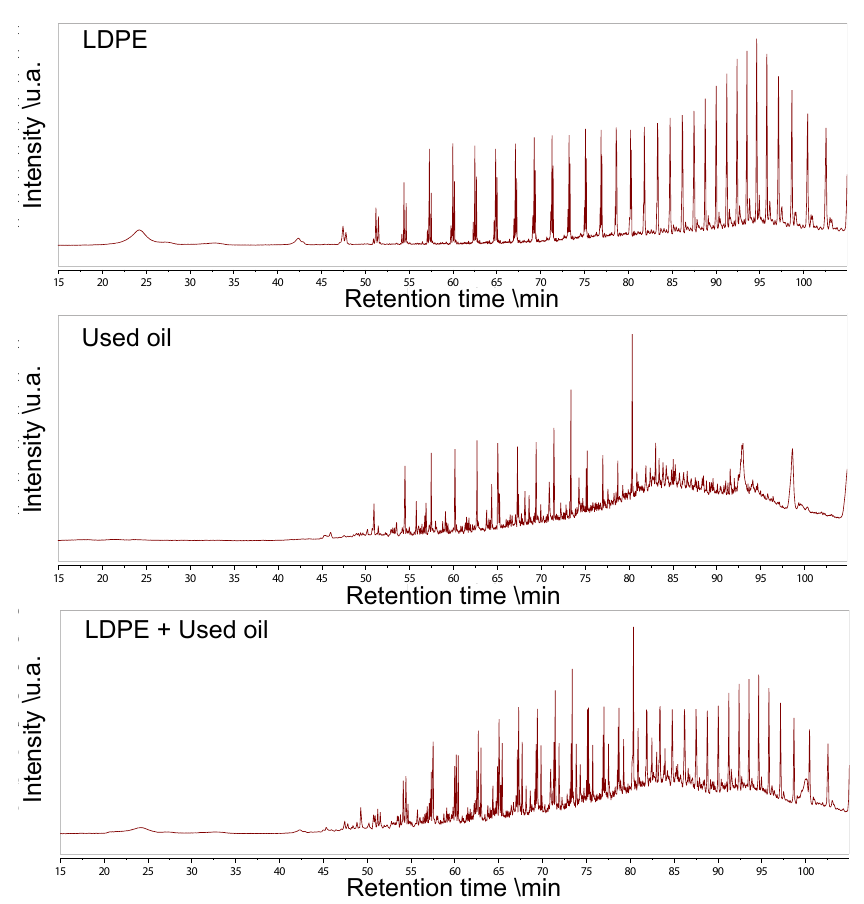
Figure 6. Resulting chromatograms of the Py-GC/MS experiments performed on LDPE, used oil, and a mixture of used oil and LDPE (50 wt% of